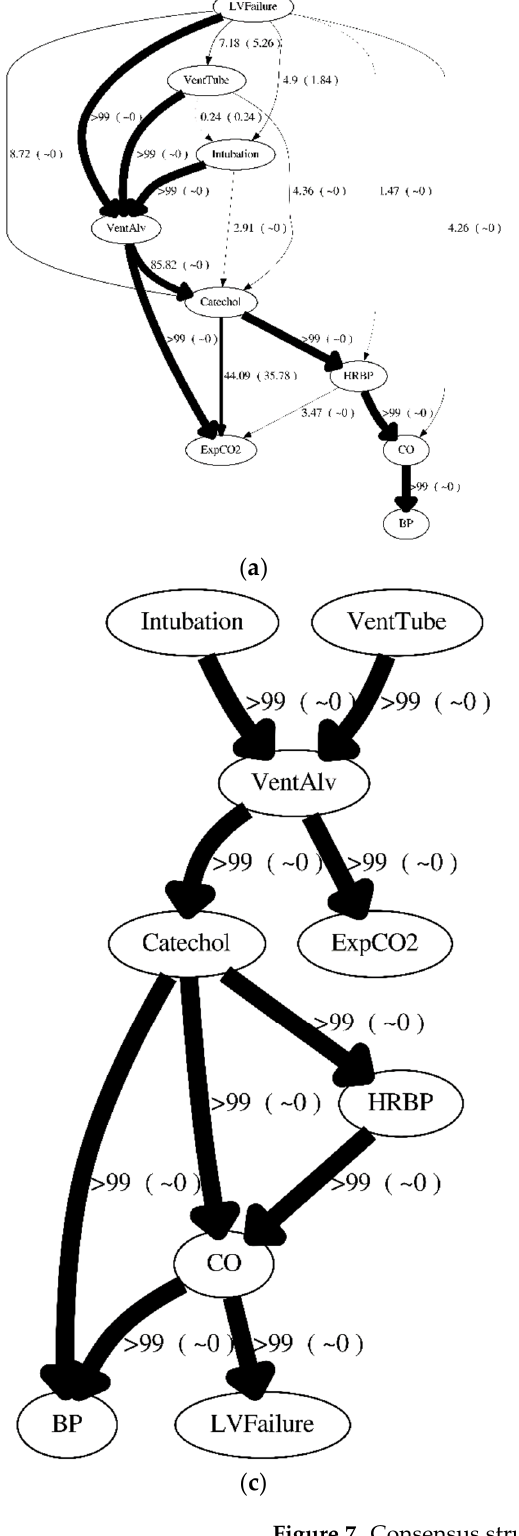
Figure 7. Consensus structure without the order weight for ( a ) D50S9, ( b ) D50C9, ( c ) D1KS9, and ( d ) D1KC9. Thicknesses of the arcs are based on the pairwise causal relationship probability that is presented as a label in percentage (the reverse causal relationship probability is presented in the parentheses). >99 and ~0 represent pairwise causal relationship probability greater than 0.9999 and less than 0.0001, respectively.